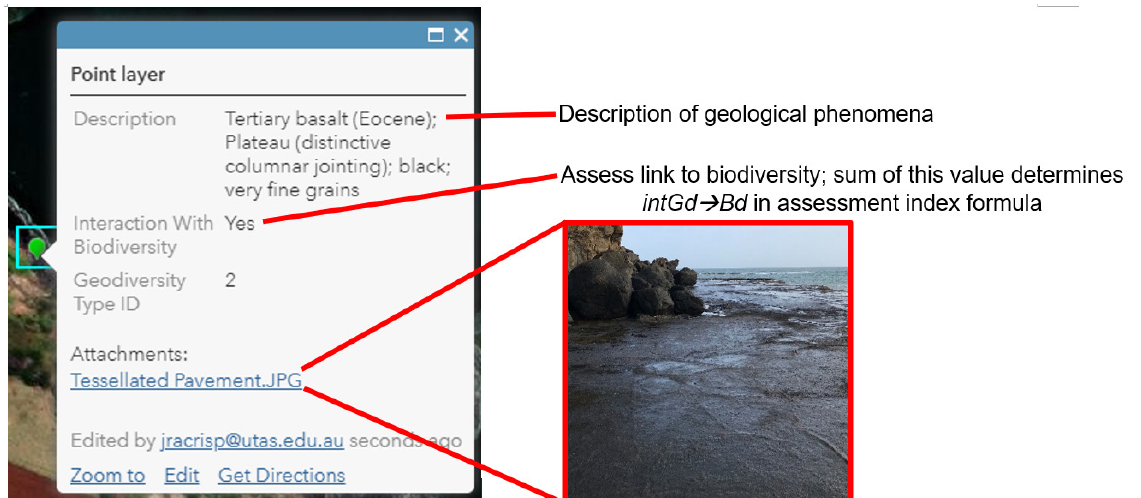
Figure 6. Example of the associated attributes of each biodiversity or geodiversity points captured in-field displayed using ArcGIS